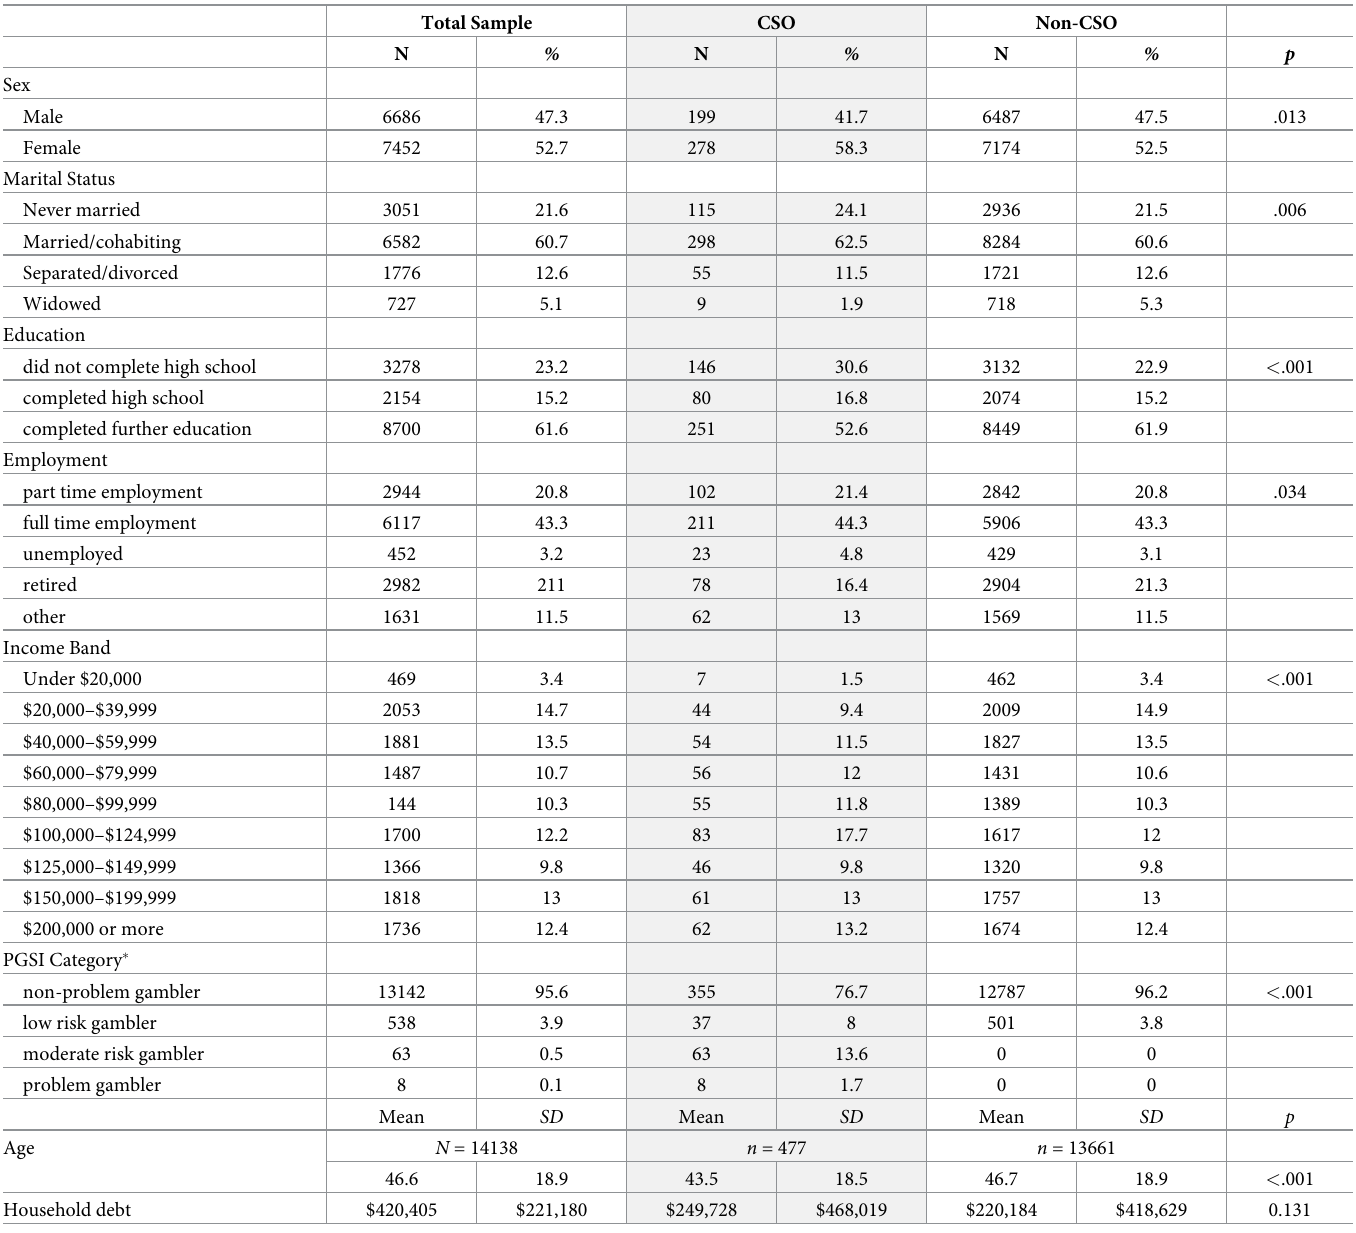
Table 1. Participant characteristics in 2018 by total sample and CSO